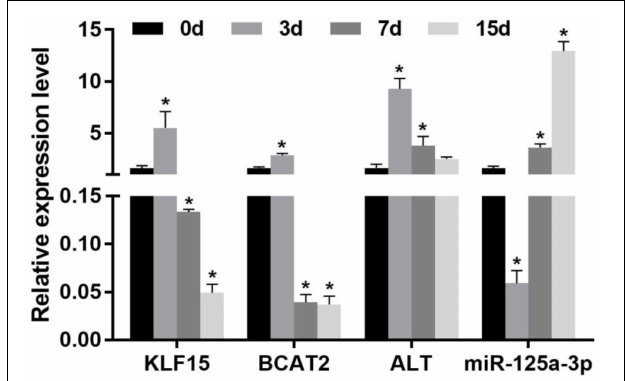
FIGURE 1 | Effect of the expression of the miR-125a-3p-KLF15-BCAA- related gene mRNA level in the skeletal muscle of Nile tilapia during starvation periods. Values represent the mean ± SE ( n = 9 fish, 3 fish were sampled for each tank). * p < 0.05 significantly different vs. 0 day. BCAA, branched-chain amino acid.